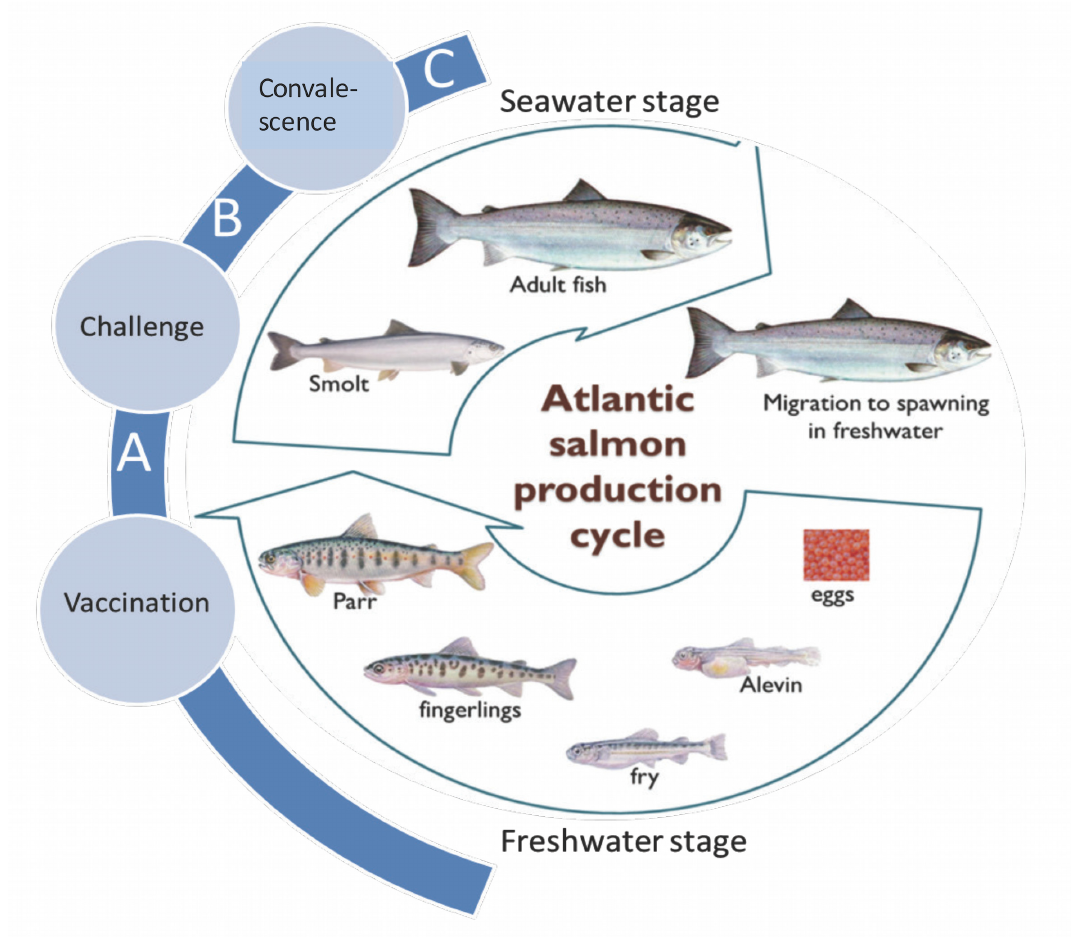
Fig 4. Salmon production cycle. The production cycle of Atlantic salmon depicting the timing of IPN vaccination, challenge and convalescence. A indicates the immune induction period being the period between vaccination and challenge. Note that vaccination is carried out at the parr stage in freshwater before smoltification. B indicates the time of challenge at the post-smolt stage soon after transfer to seawater, which conforms to the time when most outbreaks occur during the Atlantic salmon production cycle. C shows the period after lethal challenge when the survivors become carriers or persistently infected with post challenge virus during